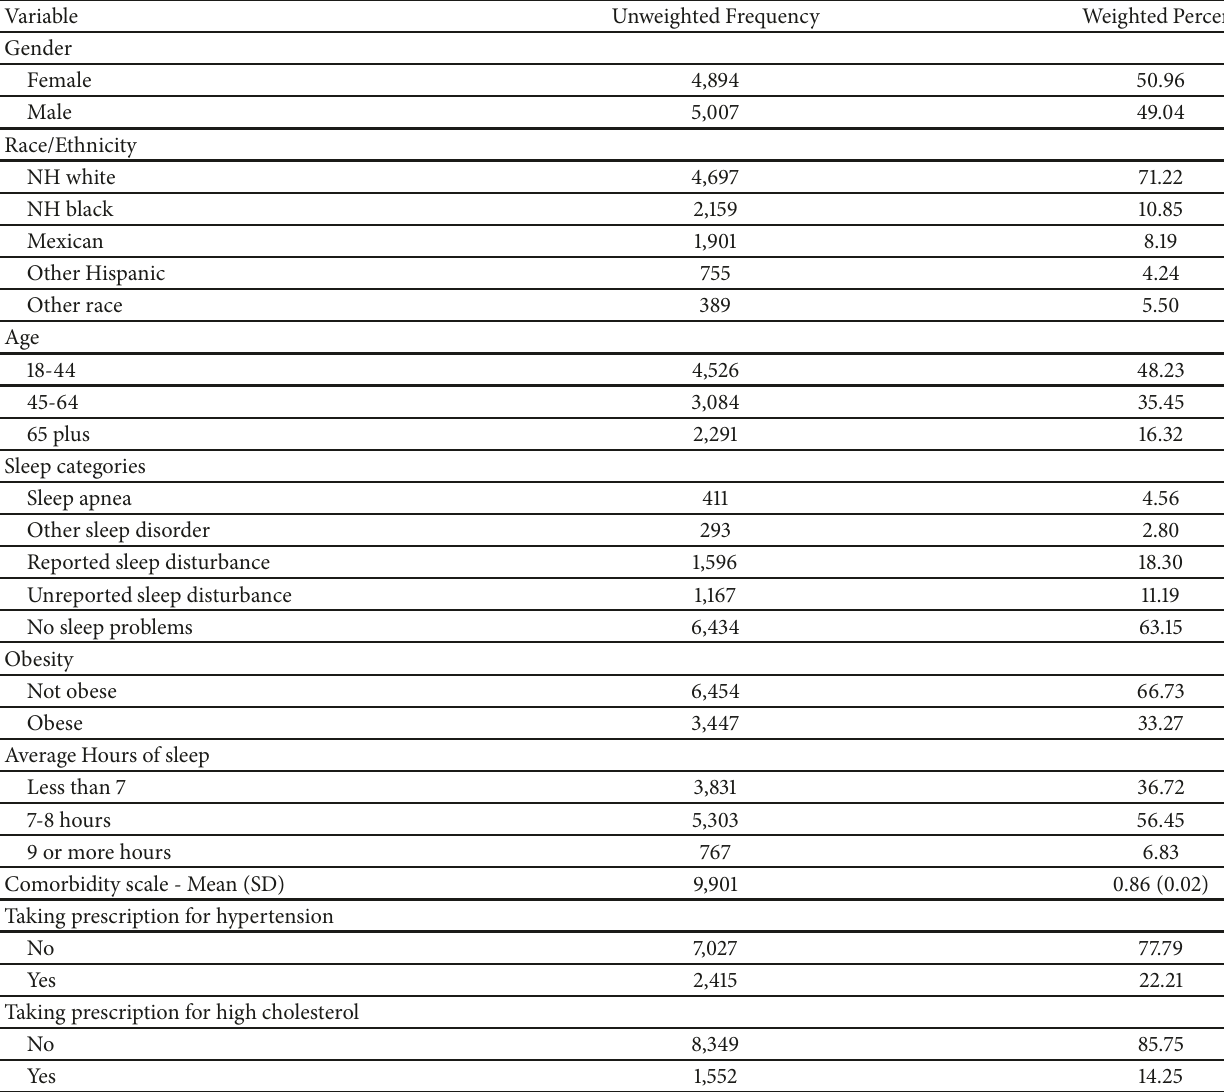
Table 1: Analysis sample frequencies and weighted percentages.